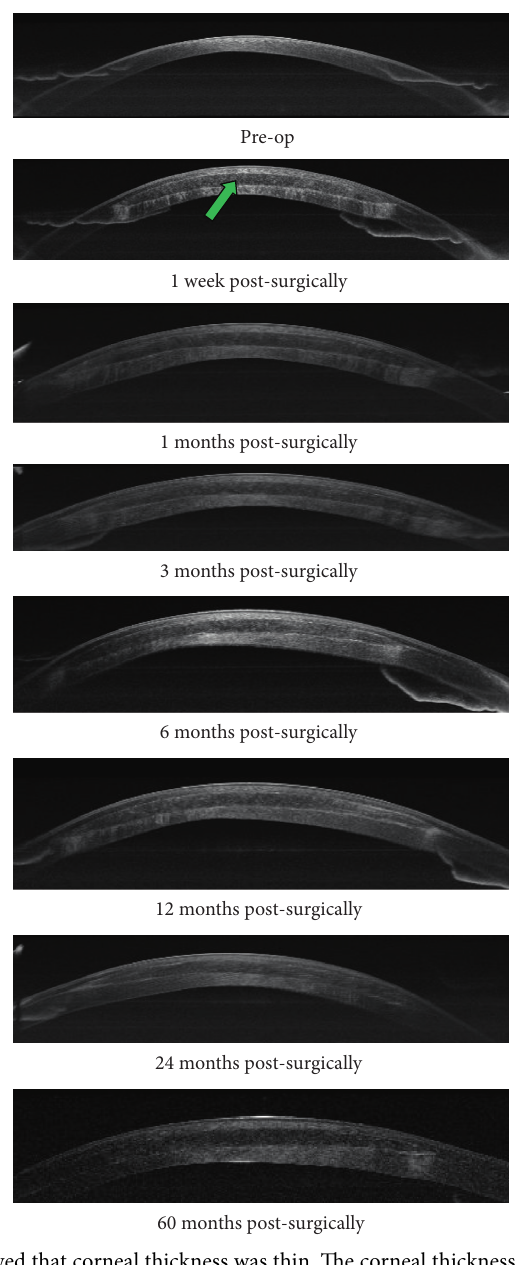
Figure 5: The preoperative images showed that corneal thickness was thin. The corneal thickness of the host increased compared with the preoperative level, and no obvious tissue reaction such as infiltrates, ulcer, and neovascularisation from the host cornea was observed (arrows indicate the lenticule and its location in the “stromal pocket”). Throughout the 60-month observation period, the corneal thickness and transparency of the recipient remained